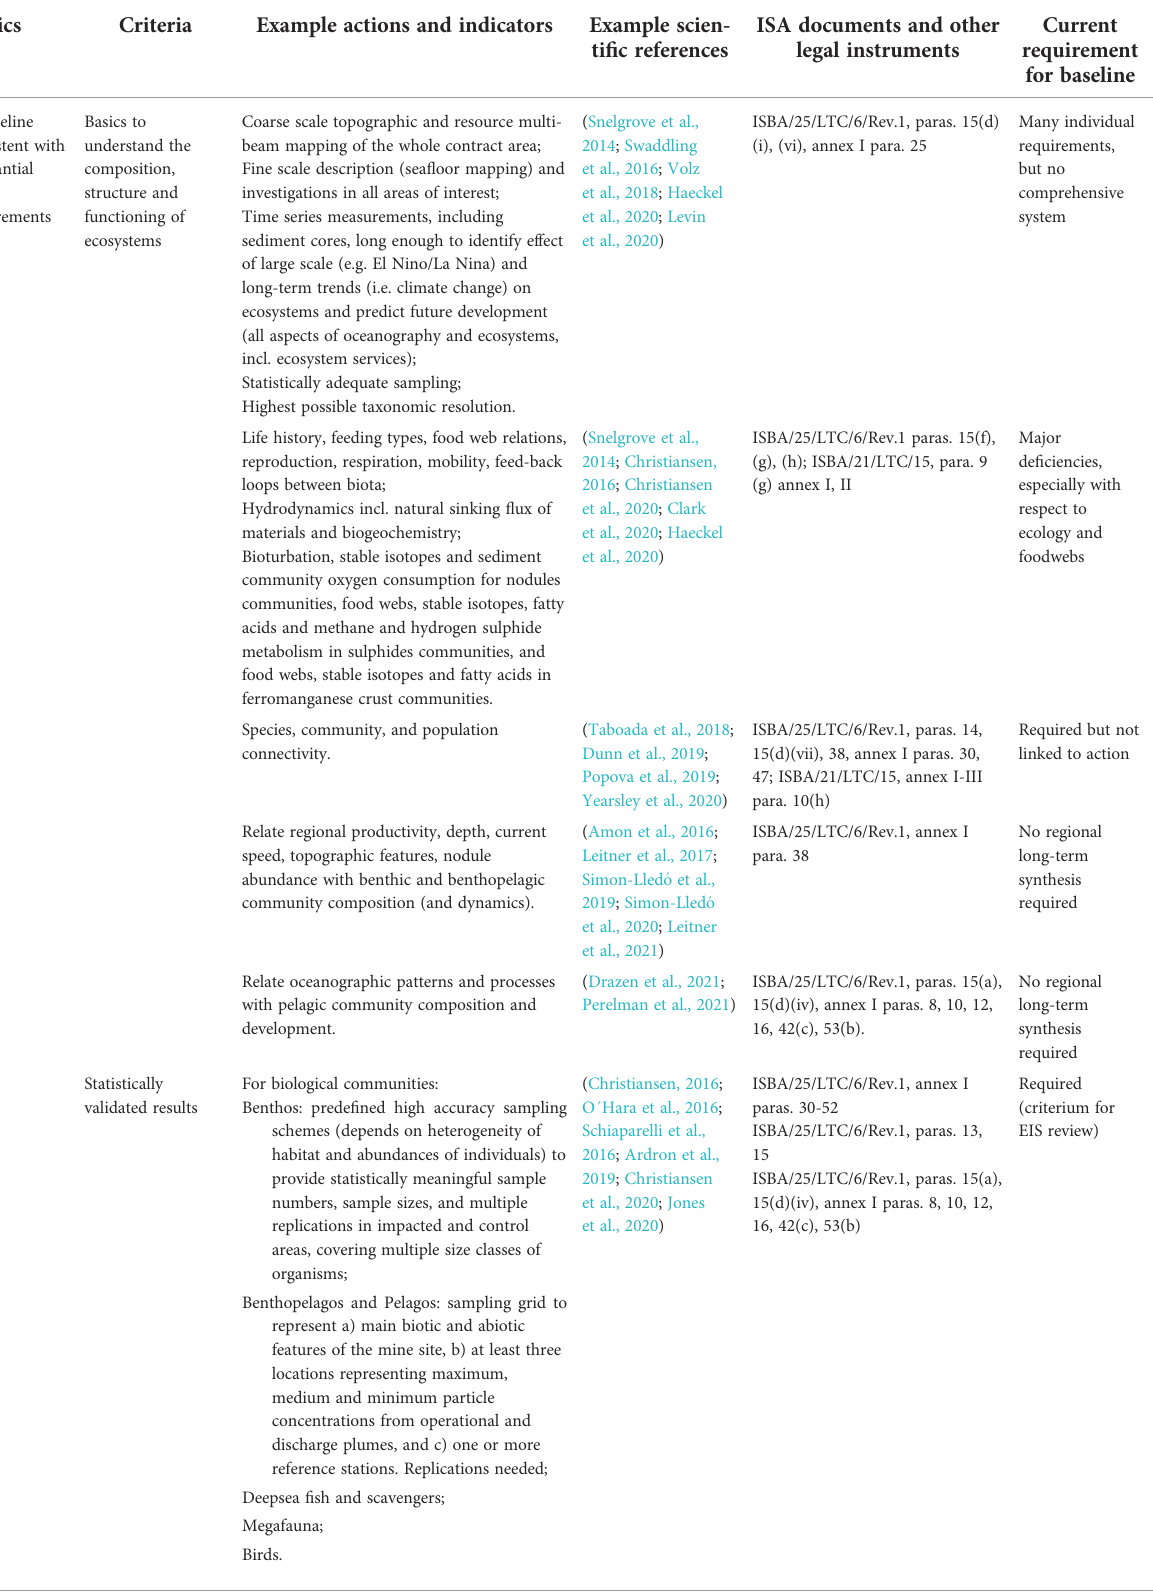
TABLE 3 Broad governance criteria and indicators for determining good baseline investigation programs and